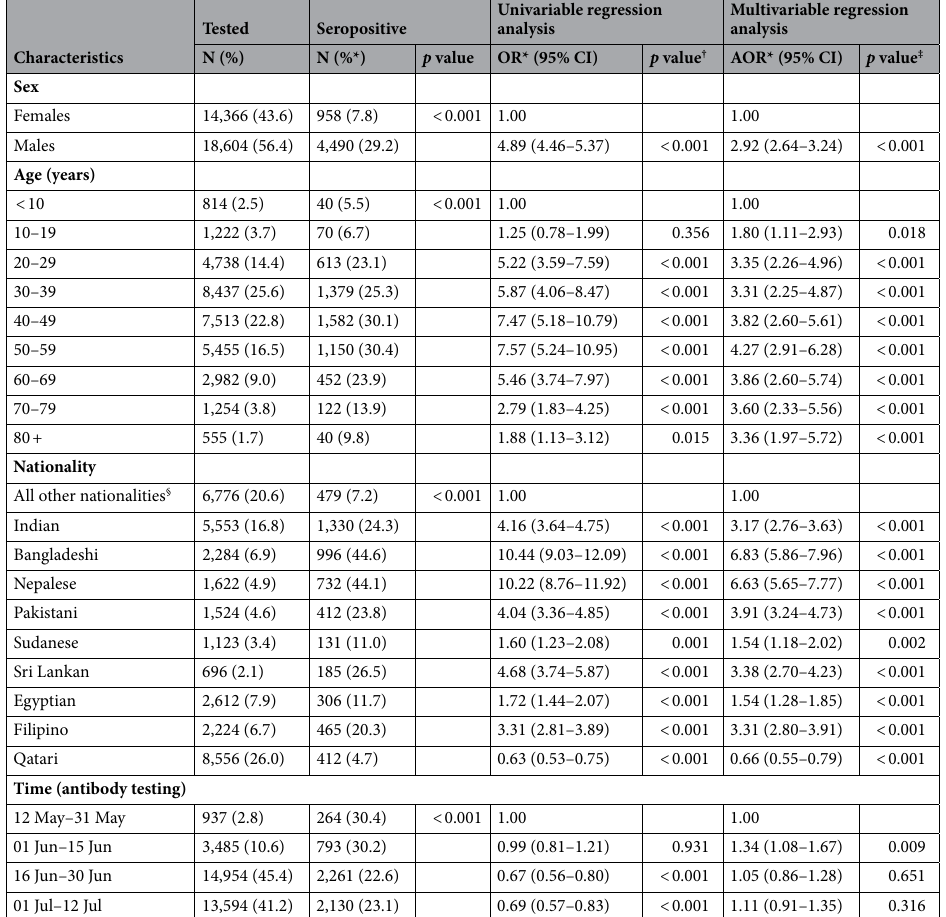
Table 5. Results of the seroprevalence survey and associations with antibody positivity. AOR adjusted odds ratio, CI confidence interval, OR odds ratio. *Estimates are weighted by sex, age, and nationality. † Covariates with p value ≤ 0.1 in the univariable analysis were included in the multivariable analysis. ‡ Covariates with p value ≤ 0.05 in the multivariable analysis were considered predictors of anti-SARS-CoV-2 positivity. § These include all other nationalities residing in